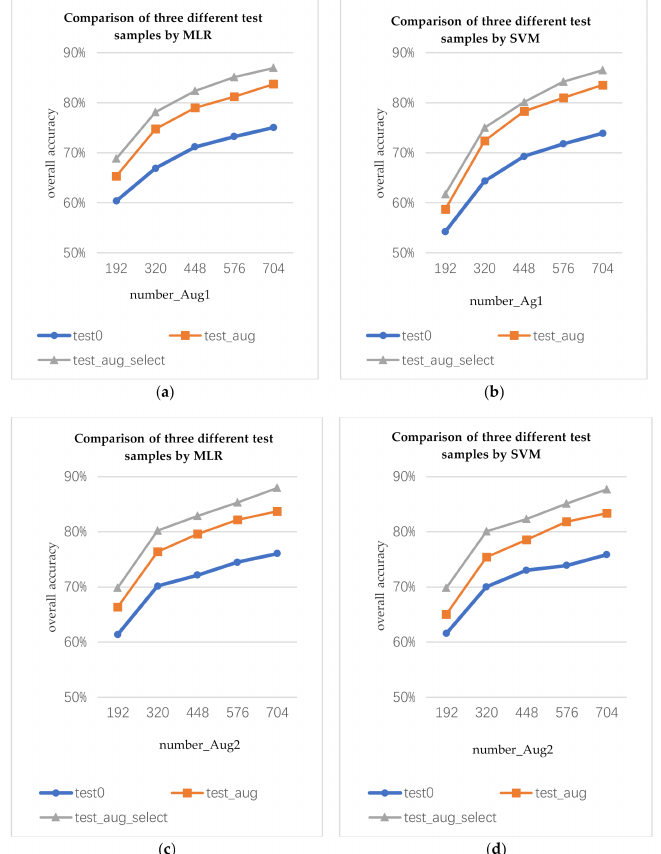
Figure 8. Comparison of classification results of three test samples on the Indian Pines data: ( a ) pre- diction results of MLR classifier trained by augmented training samples by data augmentation algorithm 1 for three test samples, ( b ) prediction results of SVM classifier trained by augmented training sample 1 for three test samples, ( c ) prediction results of MLR classifier trained by augmented training sample 2 for three test samples, and ( d ) prediction results of SVM classifier trained by augmented training sample 2 for three test